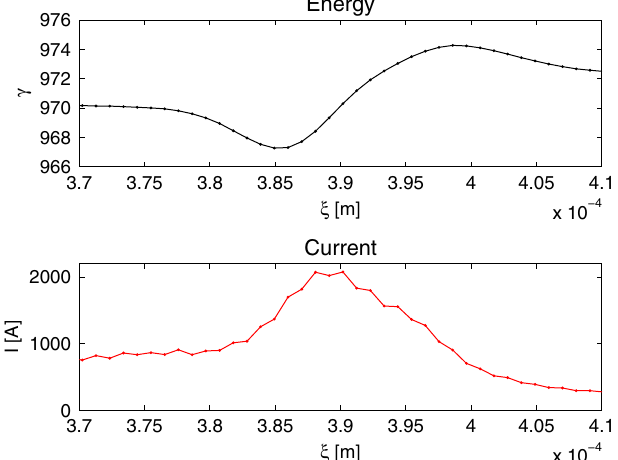
FIG. 9. (Color) Energy and current distribution along the bunch of the electron slices which produce FEL